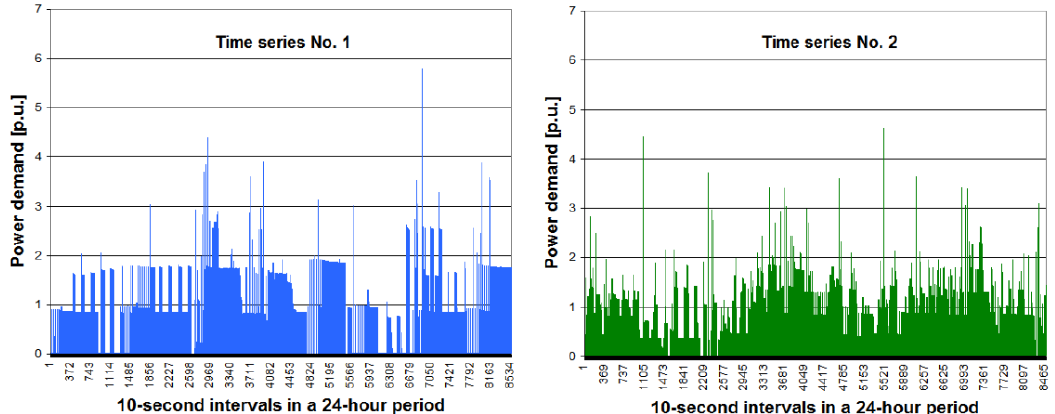
Figure 2. The two daily time series of power demand for the analyzed December day (figure of time series No. 1 is similar to the one from [44]).